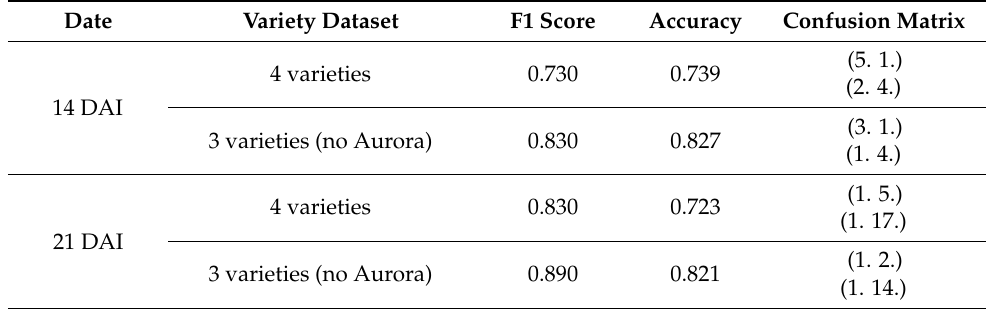
Table 1. F1 and accuracy metrics for disease detection. Depicts the F1 score and accuracy of SVM classification between the control and infection groups on 14 and 21 DAI. There were 60 wheat plants imaged (29 plants in control and 31 in infected) on 14 DAI, and 120 wheat plants were imaged (30 plants in control and 90 in infected) on 21 DAI. In the variety section, the four-variety dataset refers to Aurora, Trojan, Emu Rock, and Yitpi, and the three-verity dataset refers to Trojan, Emu Rock, and Yitpi.